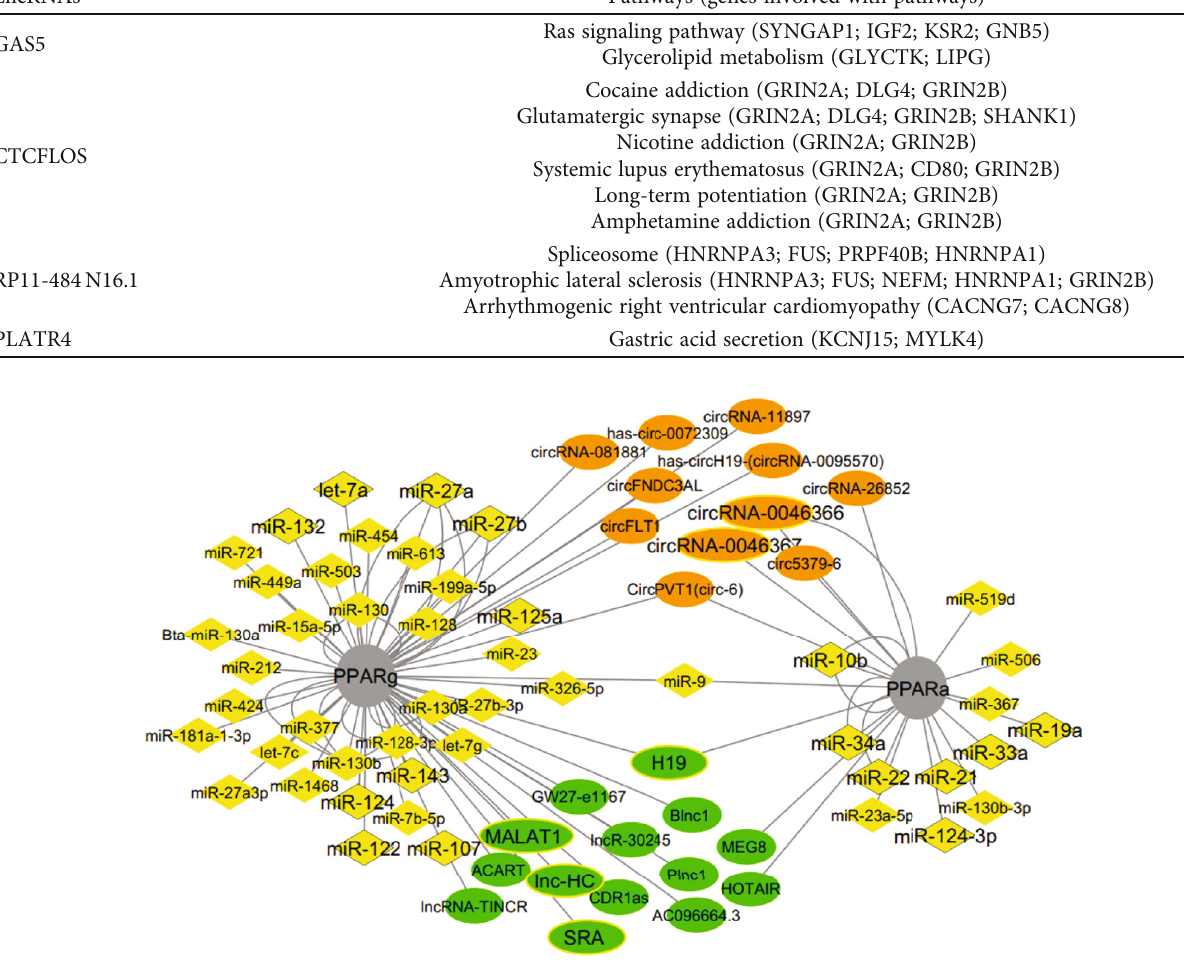
Figure 5: Strongly validated association of ncRNAs and PPARs. ncRNAs that are involved in MAFLD pathophysiology are depicted as bold titles with bordered nodes. Table 3: Causal lncRNAs and circRNAs associated with fatty liver disease and